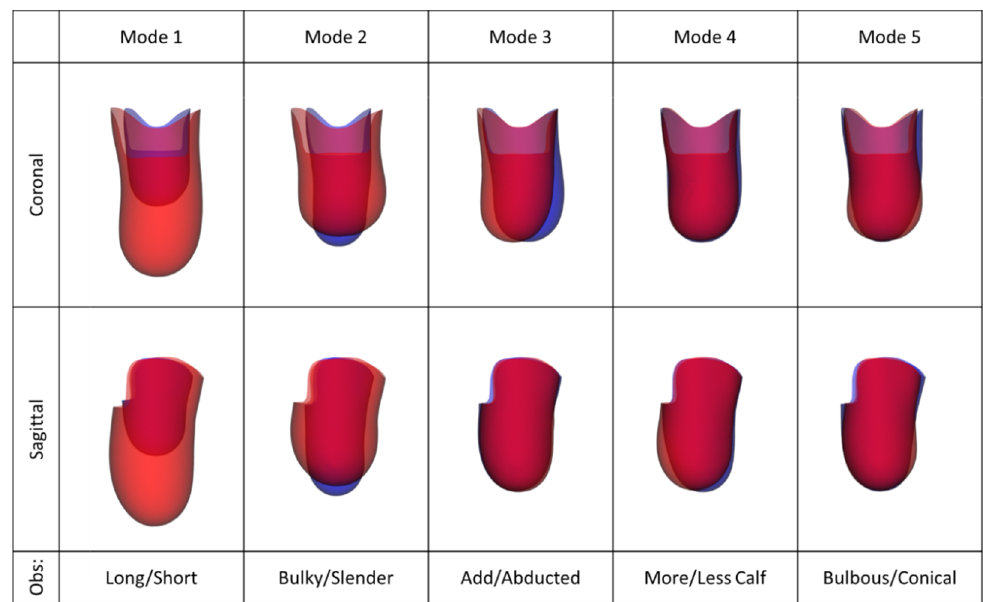
Figure 5. First five mode variations for the Statistical Shape Model (SSM), showing ±2 standard deviation shapes either side of the mean. Shape variation observations (Obs) are labelled.